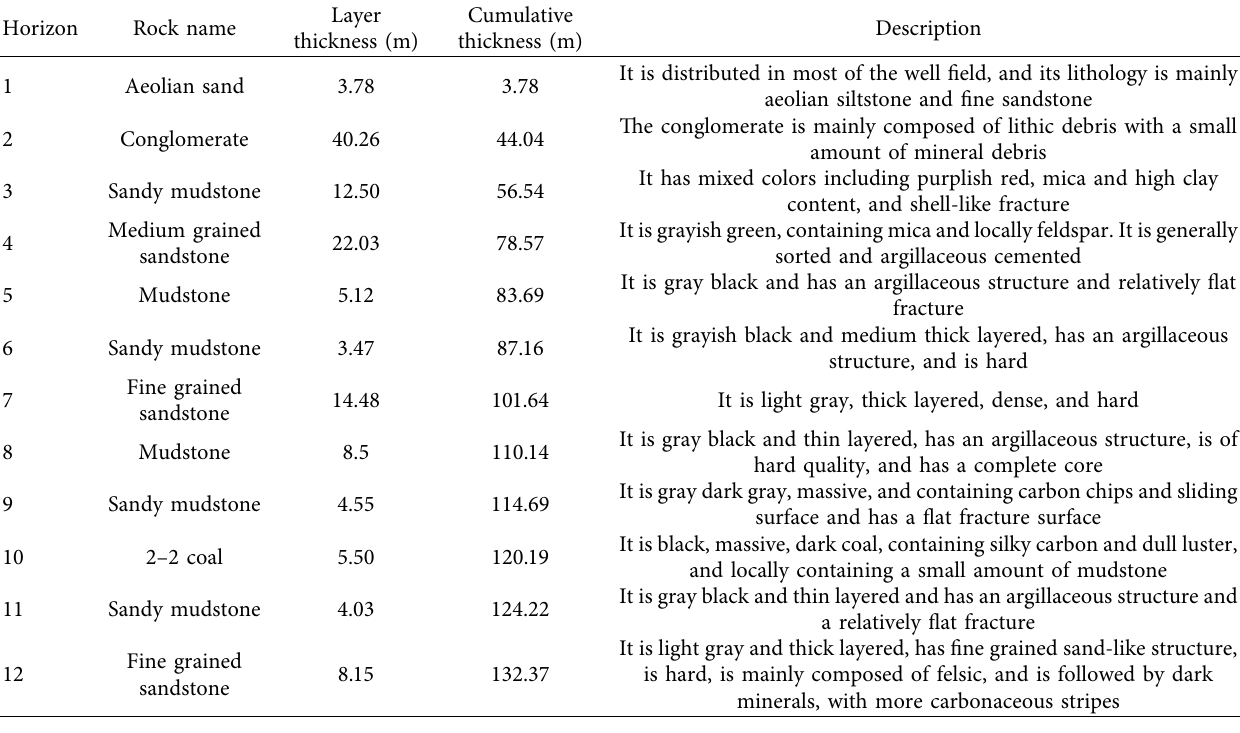
Table 1: Comprehensive histogram of 2201 working face.